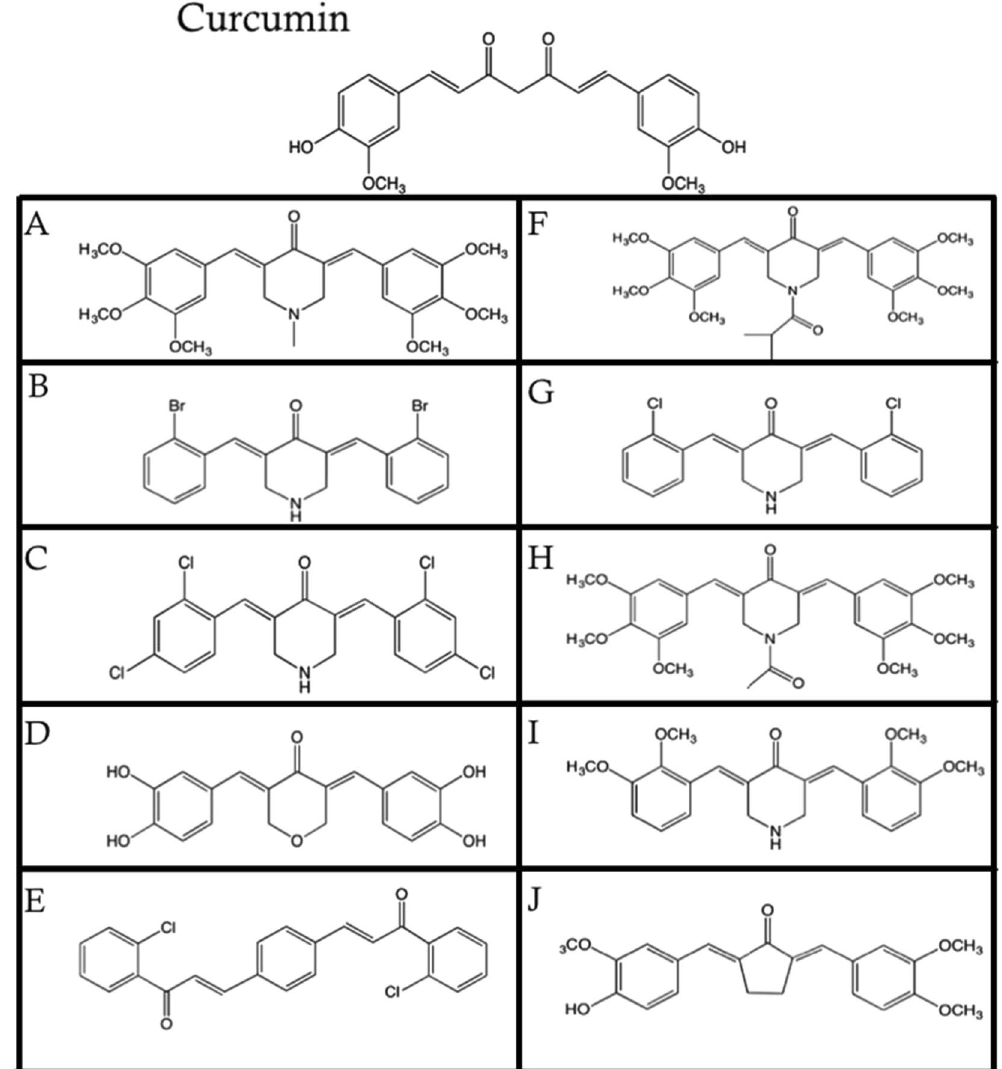
Figure 1. Chemical Structure of Curcumin and Analogs of